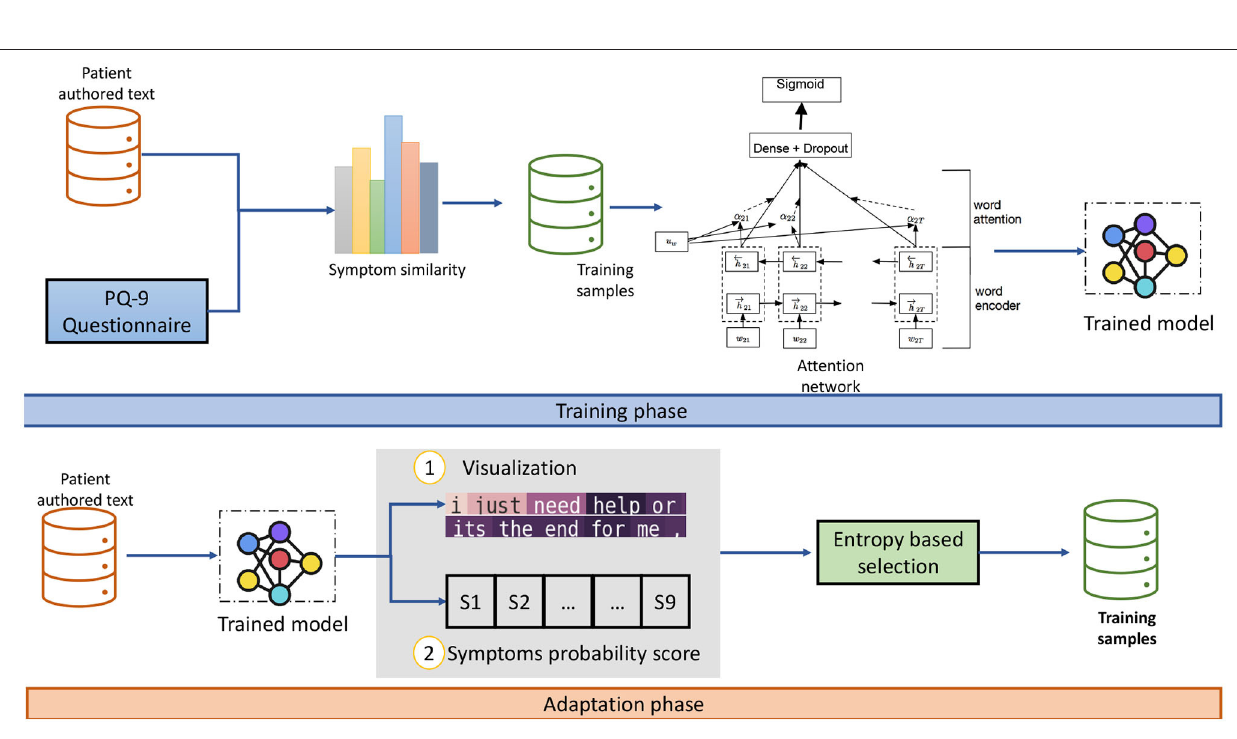
FIGURE 2 | A flow of training and adaption using attention based domain adoption. The visualization and symptoms similarity is suggested for the psychiatrist for note-making and suggesting patient remedy for certain